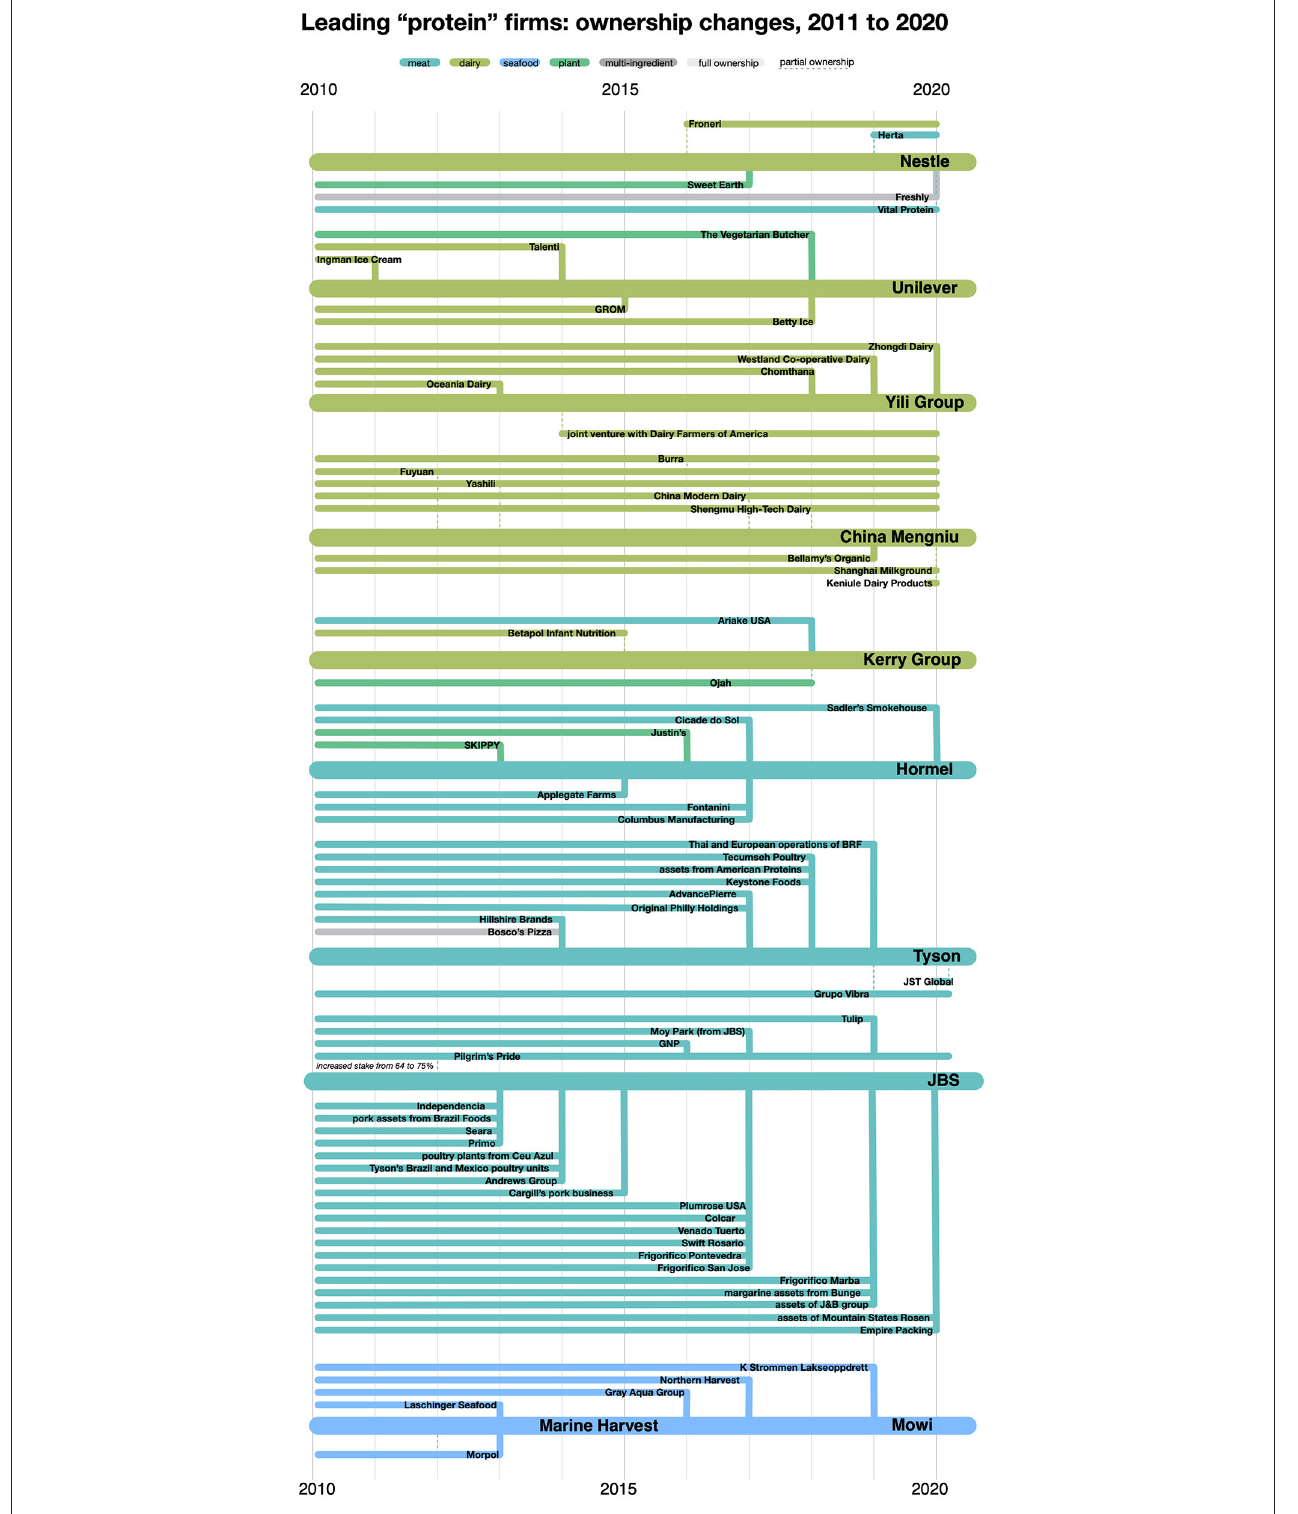
FIGURE 4 | Timeline of leading “protein” firms: ownership changes, 2011–2020.